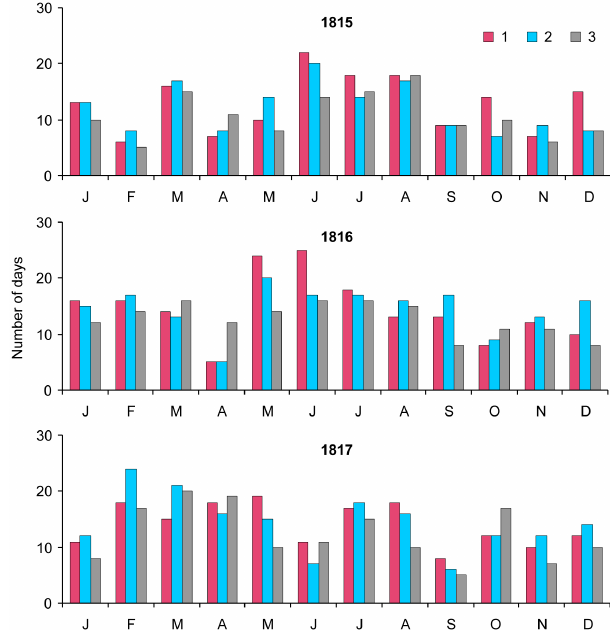
Figure 6. Fluctuations in the monthly numbers of